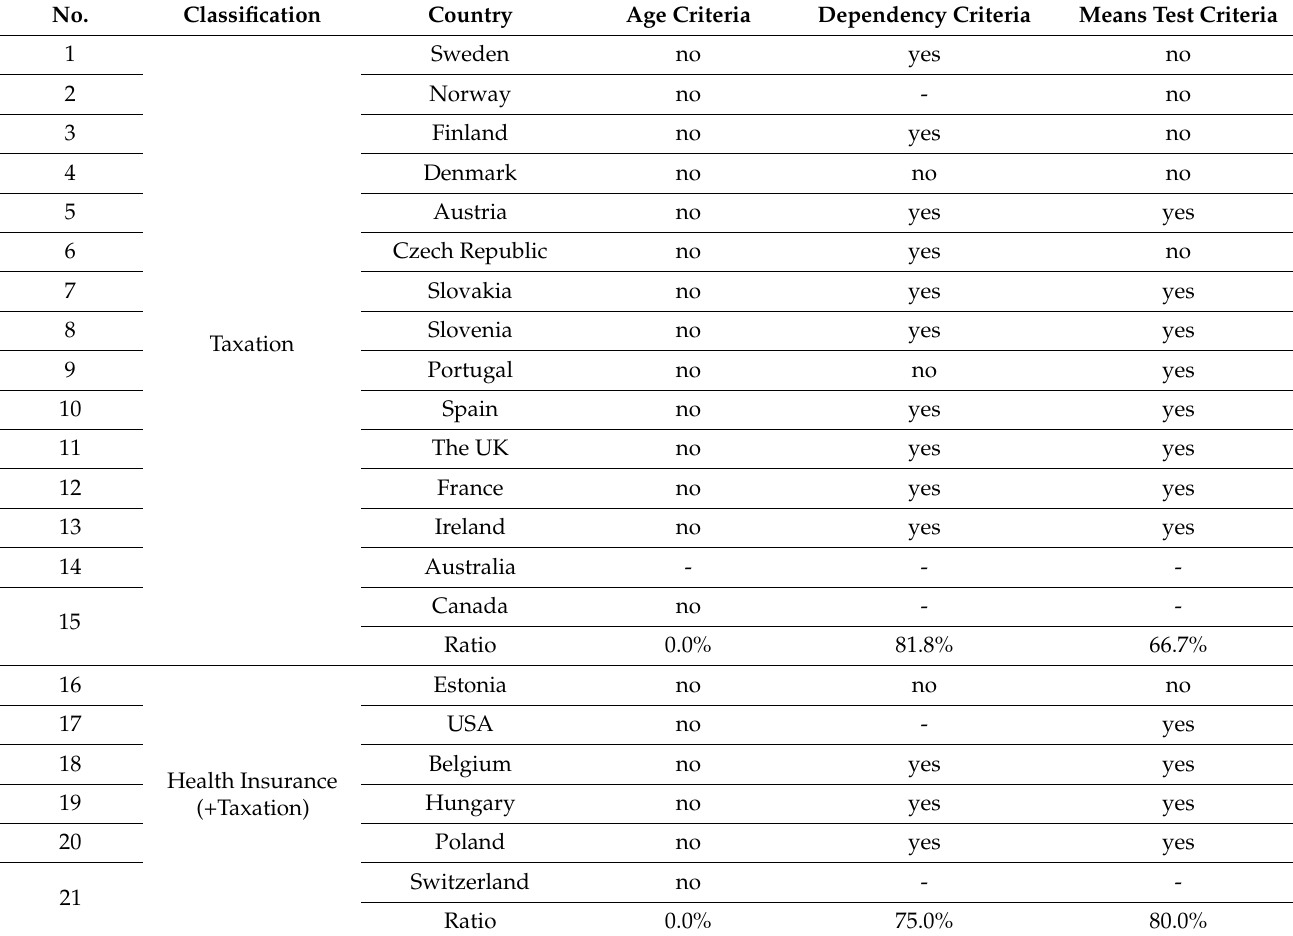
Table 3. Comparison of long-term care system eligibility criteria according to each OECD country [20]. No. Country Age Criteria Dependency Criteria Means Test